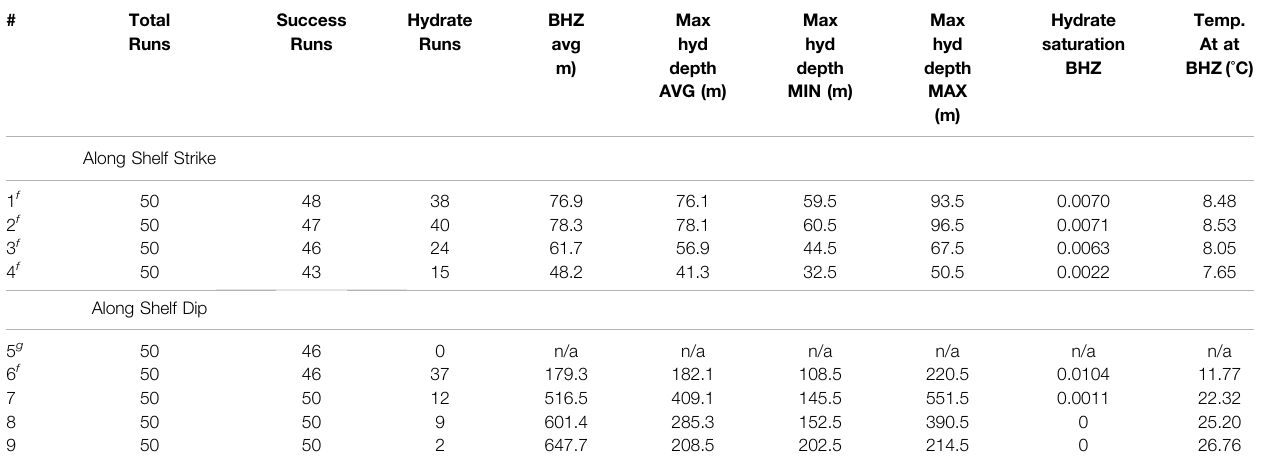
TABLE 4 | Summary of hydrate pro fi les modeled with PFLOTRAN and Dakota (gas locations g and feather edge locations f